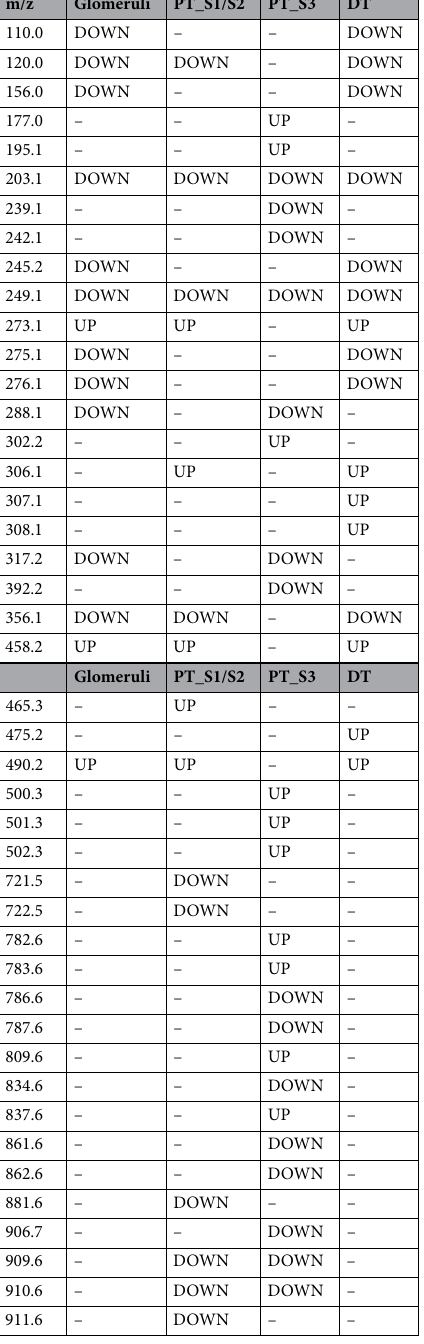
Table 1. Metabolic features that are more (UP) or less (DOWN) abundant in glomerular, proximal tubular and distal tubular segments when comparing control and diabetic